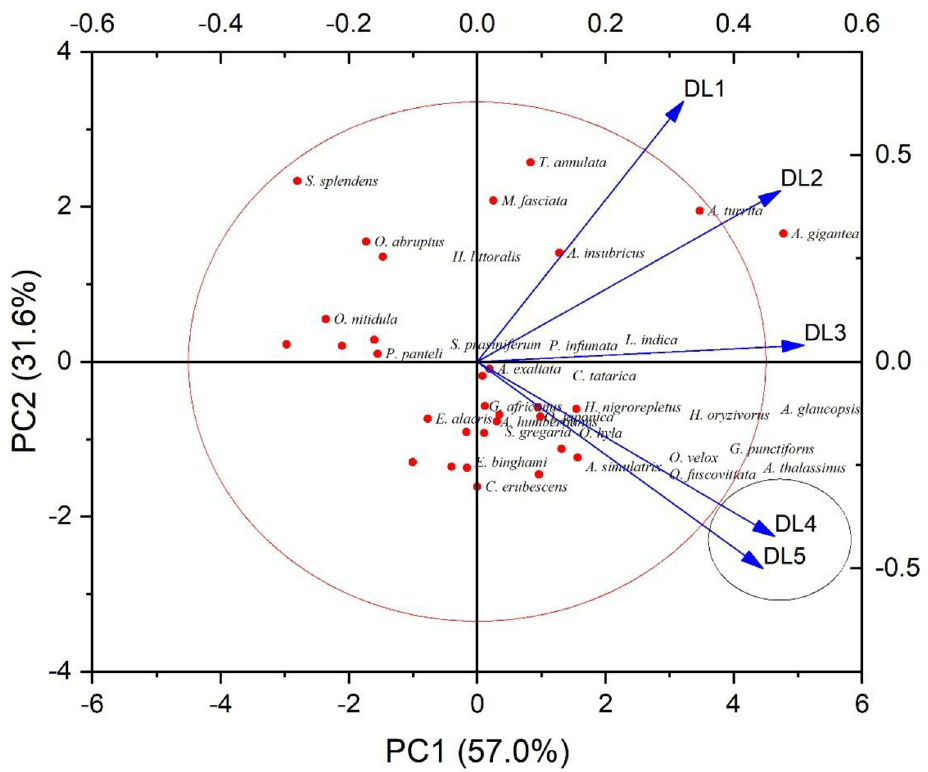
Fig 4. A bi-plot of principal components (PC1, 57%; PC2, 31.6%) for 31 acridid species. The PCA is classified according to the mortality percentages (M%) (response) acridids at different doses (DL1 to DL5). The cluster of DL4 and DL5 indicates a non-significant response, whereas the dispersed DLs (DL1, DL2, and DL3) indicate significant mortality